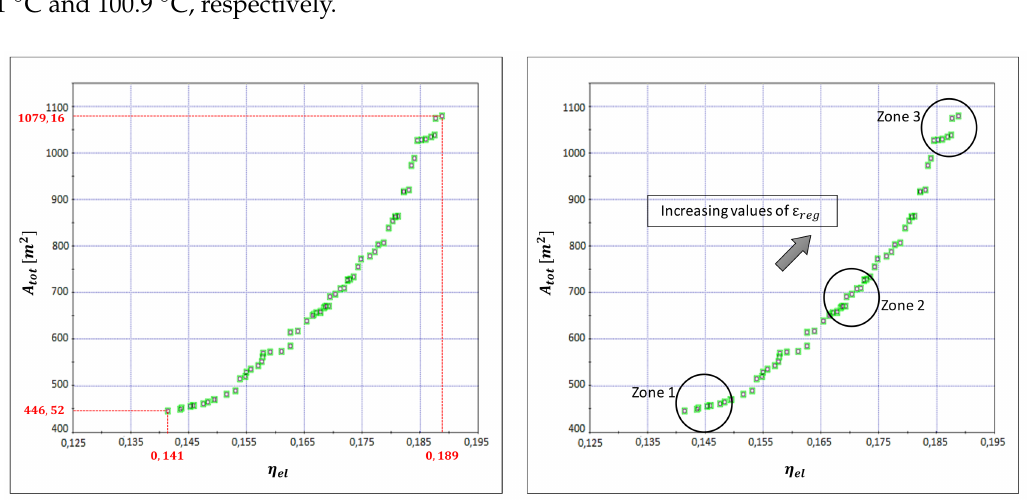
Figure 13. Pareto optimal front and clustering of the calculated solutions. In this figure, the comma is used as a symbol to separate the integer part from the fractional part of a